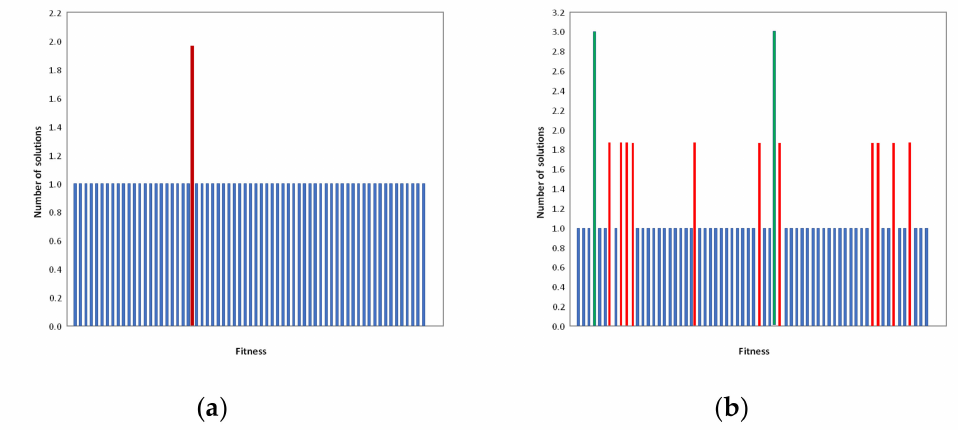
Figure 14. The cost of density in case of 2-opt ( a ) and order crossover operator ( b